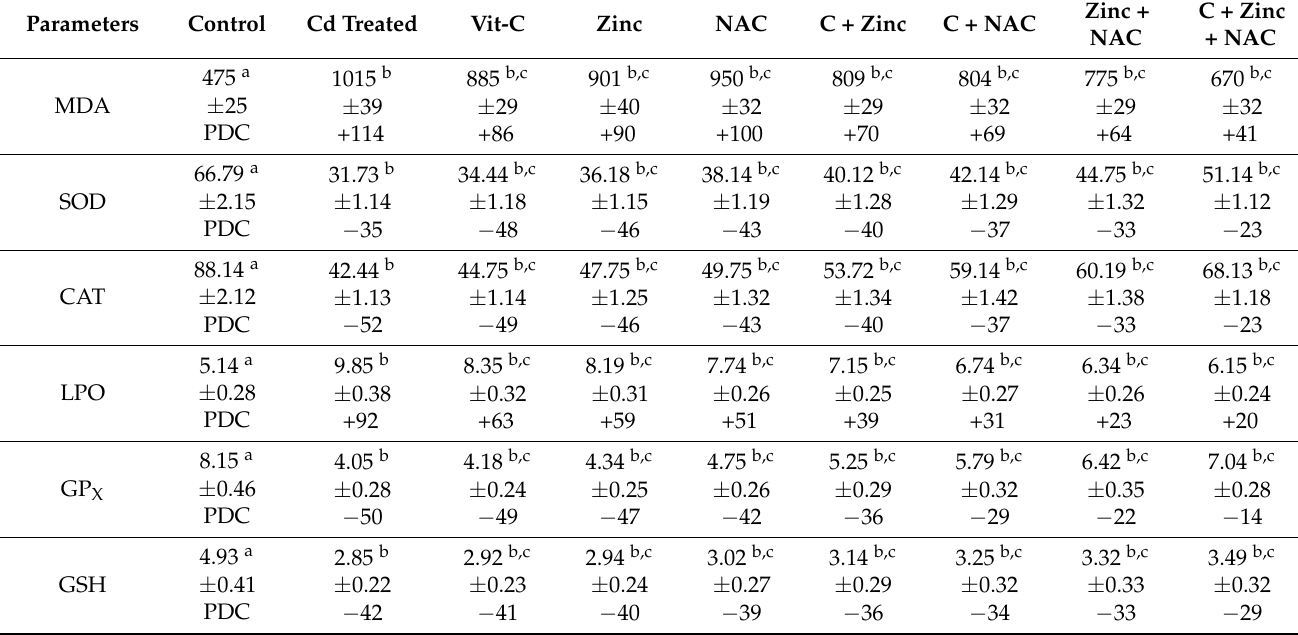
Table 4. Levels of Antioxidant Enzymes and Products in Liver tissue of Control and Experimental rats.